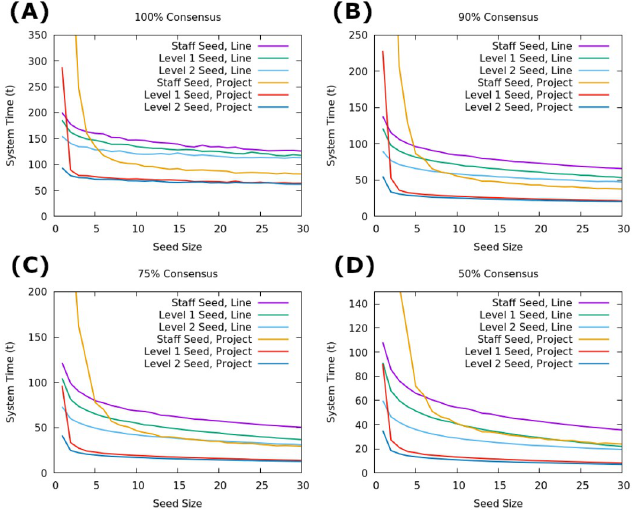
Fig 4. Time to consensus in SI framework. Time to different levels of consensus with an absorbing I state for varying seed sizes, averaged over 1000 runs. A: Time to 100% consensus. B: Time to 90% consensus. C: Time to 74% consensus. D: Time to 50%